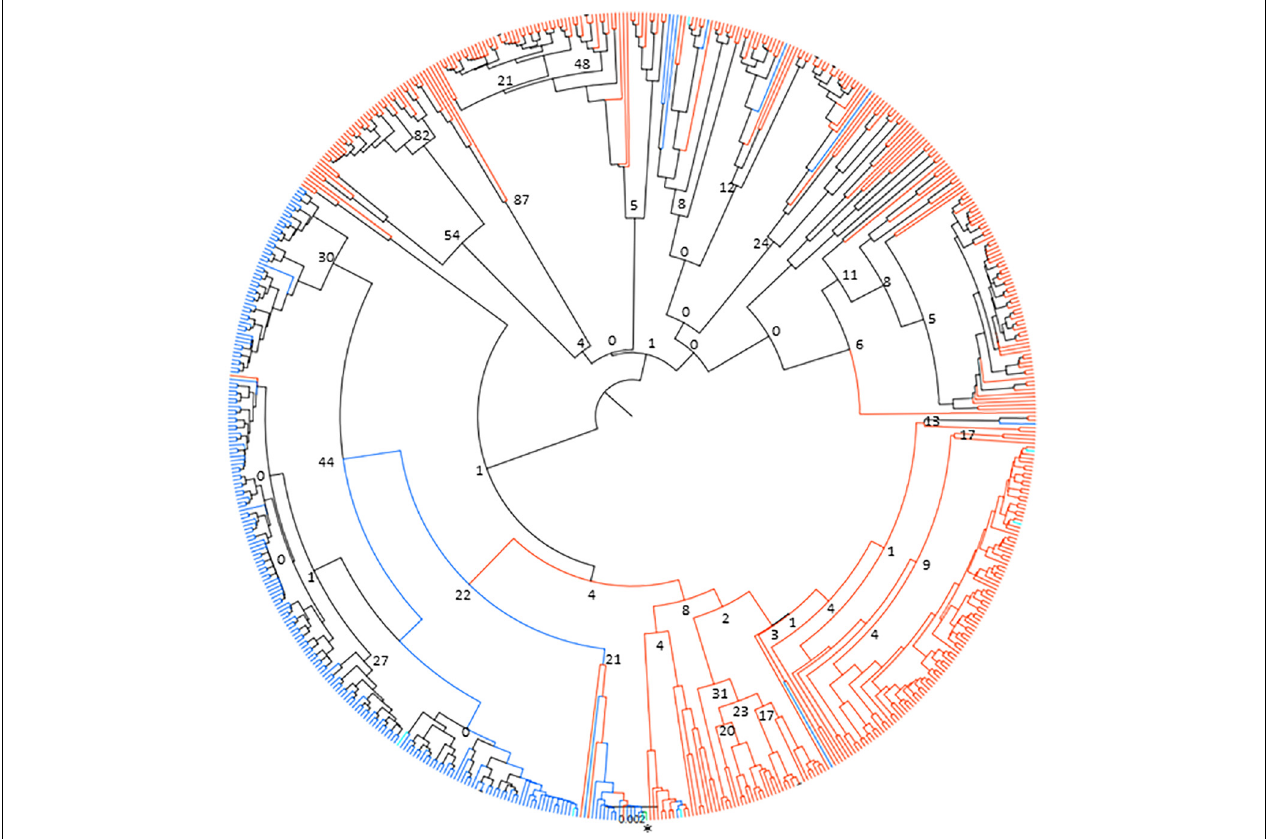
FIGURE 5 | Neighbor-joining phylogenetic tree of 651 Tp1 alleles found in cattle and buffalo samples. Alleles only found in cattle are shown in blue, alleles only found in buffalo are shown in orange and alleles present in both cattle and buffalo are shown in turquoise. The TpM reference sequence allele is highlighted in green and marked with an asterisk. Bootstrap values are shown at selected tree